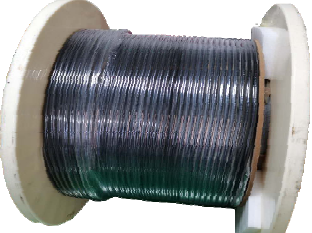
Fig. 30 Optical fiber hydrophone cable for distributed underwater acoustic